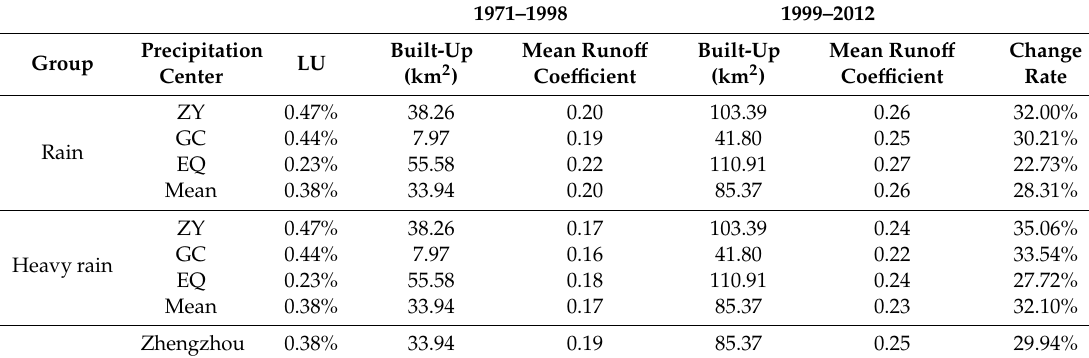
Table 7. Statistics of runo ff coe ffi